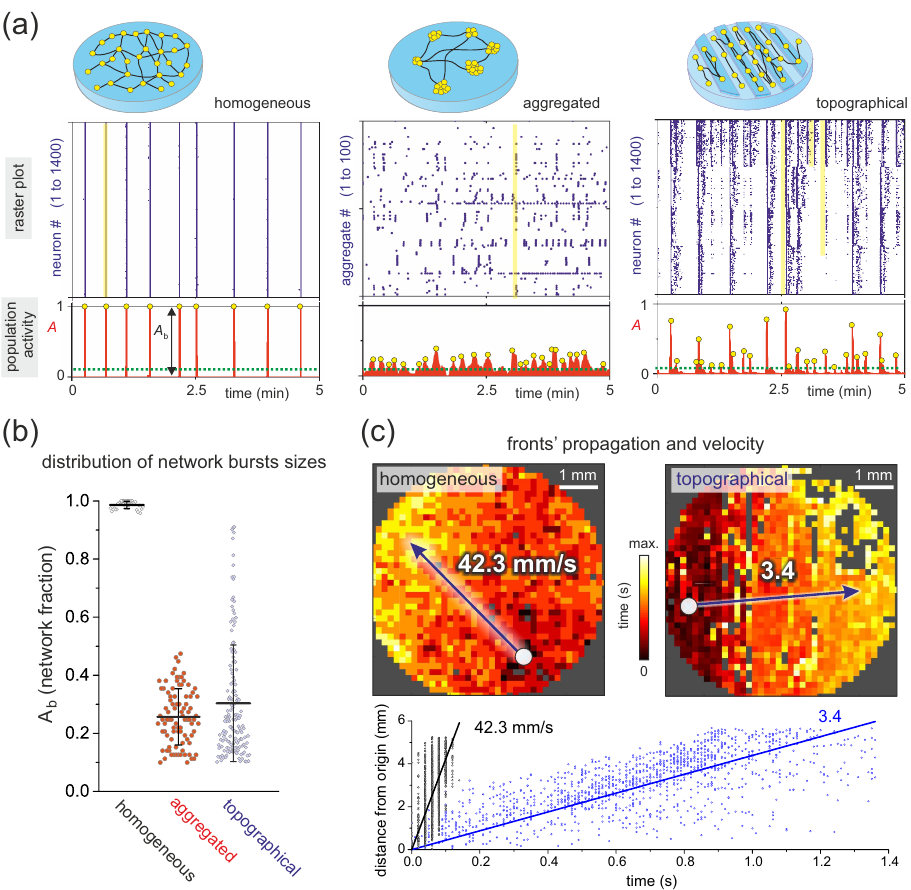
Figure 4. Data analysis. ( a ) spontaneous activity in three different neuronal culture configurations, obtained from recordings with GCaMP6s as calcium indicator. The collection of inferred spikes is visualized in the form of raster plots (top plots, each blue dot corresponding to a spike). Collective activity events or network bursts appear as bands of coherent activity (yellow outline). Population activity (bottom plots) is quantified by vertically summing up the raster plot. Strong network bursting leads to sharp peaks in the signal, denoted A b . ( b ) The distribution of A b values reveals the richness in dynamical states of the network. Homogeneous cultures are locked in a strong bursting behavior and A b (cid:39) 1 in all events, while aggregated and topographical cultures exhibit a broader distribution; ( c ) top, each individual network burst can be analyzed to portray its spatiotemporal structure (black- yellow color pattern) and initiation point (white circle). Bottom, the data of activity propagation can be plotted to obtain the characteristic propagation velocity as a linear fit. In the examples shown, front propagation in a topographical substrate is about 10 times slower than in a homogeneous